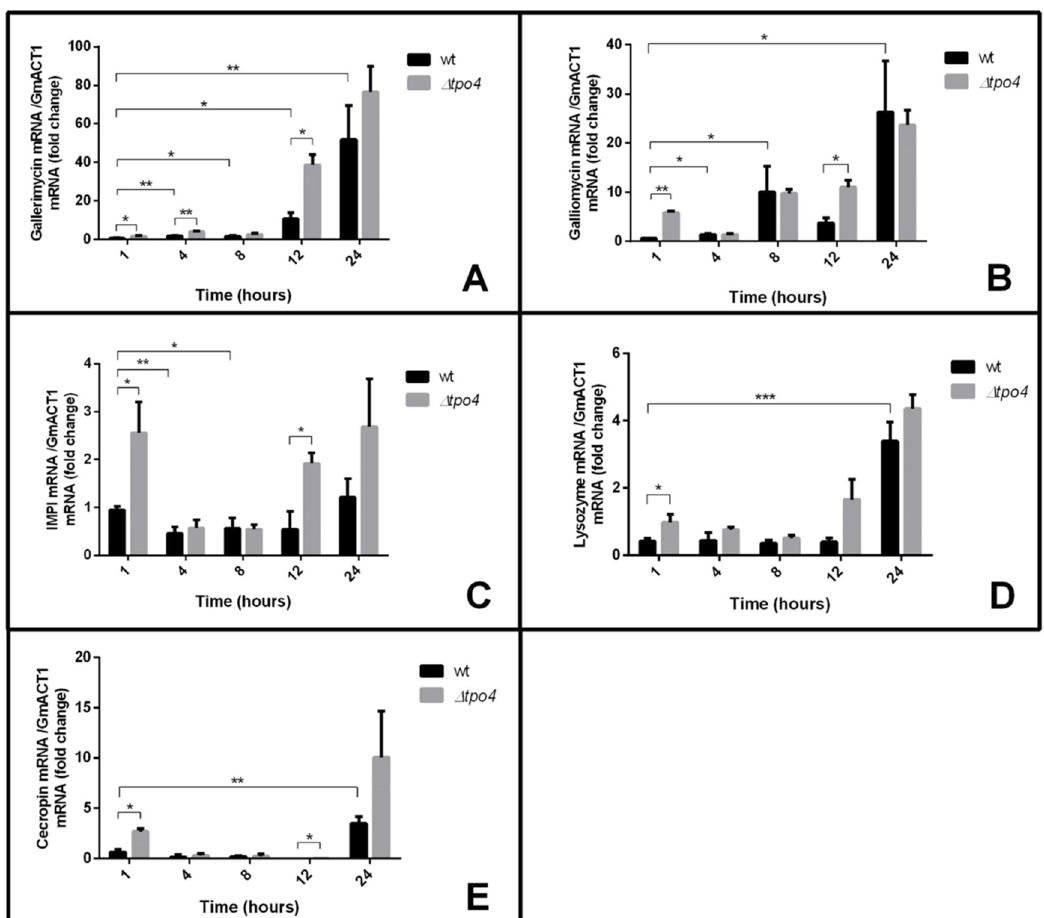
Figure 3. Expression of genes encoding antimicrobial peptide (AMPs) is activated in G. mellonella , during infection by C. glabrata . Comparison of the variation of the gallerimycin ( A ), galliomycin ( B ), inducible metalloproteinase inhibitor (IMPI) ( C ), lysozyme ( D ) and cecropin ( E ) transcript levels in G. mellonella , after 1, 4, 8, 12, and 24 h of infection by KUE100 C. glabrata wild-type cells (black bars) and derived Δcgtpo4 mutant cells (grey bars). The presented transcript levels were obtained by quantitative RT-PCR and are normalized to the GmACT1 mRNA levels, relative to the values registered in G. mellonella larvae, in the same time points, treated with PBS buffer as a control. The indicated values are averages of at least three independent experiments. Error bars represent the corresponding standard deviations. * p < 0.05; ** p < 0.01; *** p < 0.001.